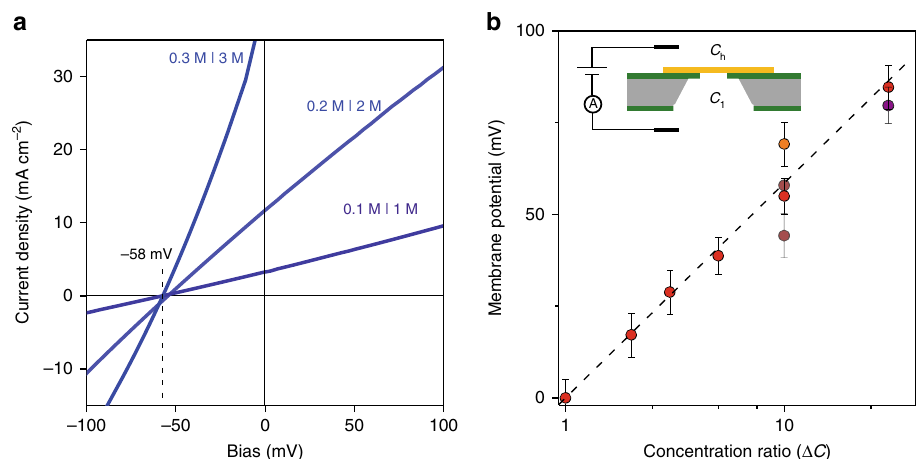
1 Fig. 2 Proton selectivity. a Examples of I – V characteristics for various HCl concentrations across a monolayer hBN membrane at a fi xed Δ C = 10. The current at zero voltage (intersection with the y axis) was always positive. The reversal potential V 0 is given by the intersection of the I – V curves with the x axis and was V 0 ≈ − 58 mV as marked by the dotted line. b V 0 for different Δ C and four different hBN devices (symbols of different color). Error bars, SD from different measurements. The black line is given by Eq. (1) for t H = 1 and t Cl = 0. Inset: Schematic of the experimental